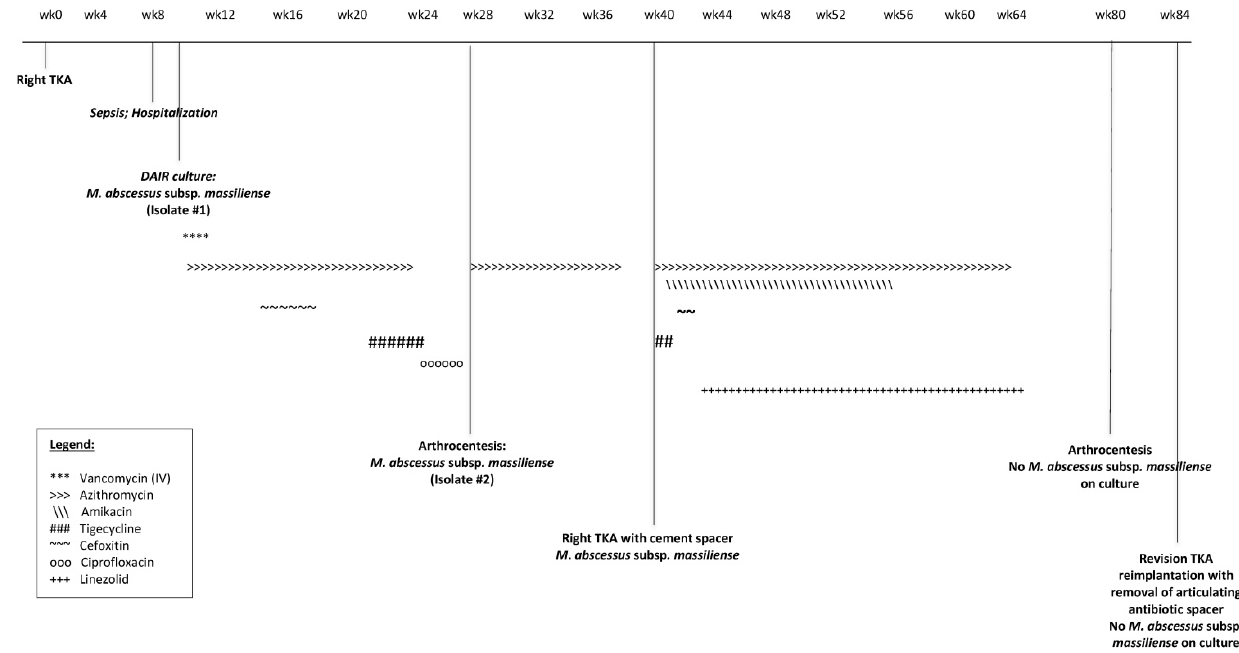
self-referred to our institution for an infectious